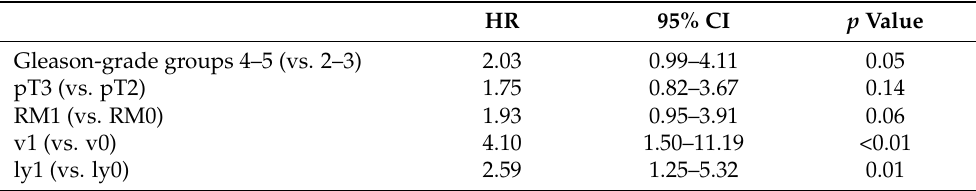
Table 4. Multivariable analyses of associations between various parameters and BCR only in patients with pN0.